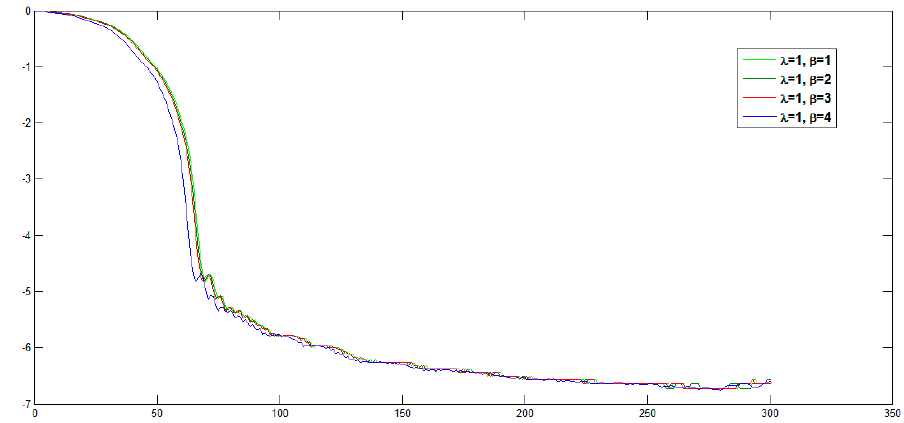
Figure 9. Comparison of reconstruction errors with different choices of parameters of GFLMs.